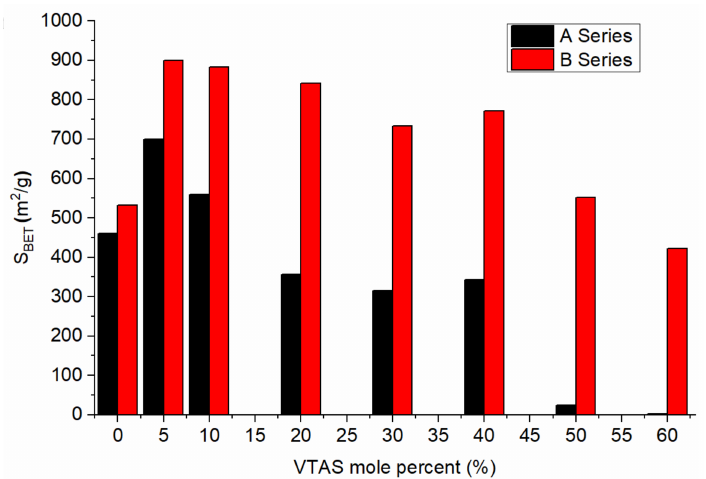
Figure 3. Influence of the molar ratios of the precursors and the types of catalysts upon the specific surface area of the synthesized silica gels.